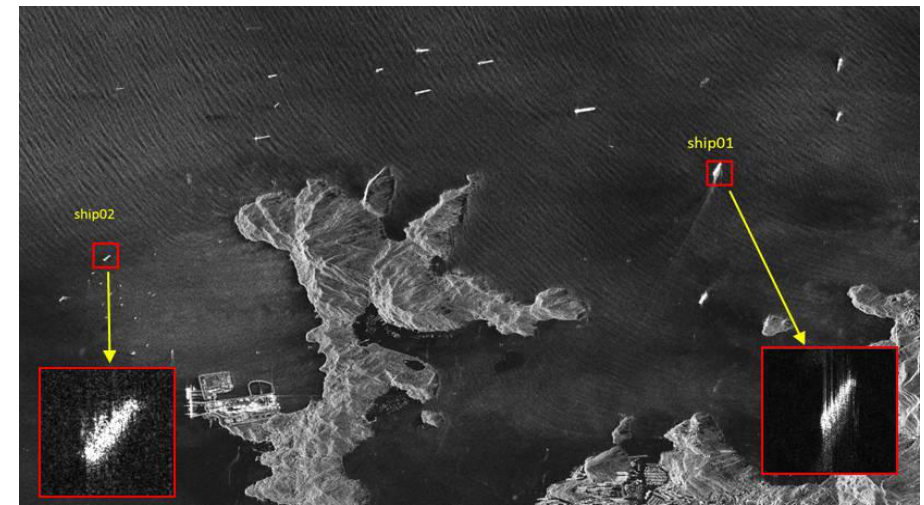
Figure 5. Two defocused ships detected in a TerraSAR-X image (sub-images of ship01 and ship02). The red rectangles are the zoomed sub-images.